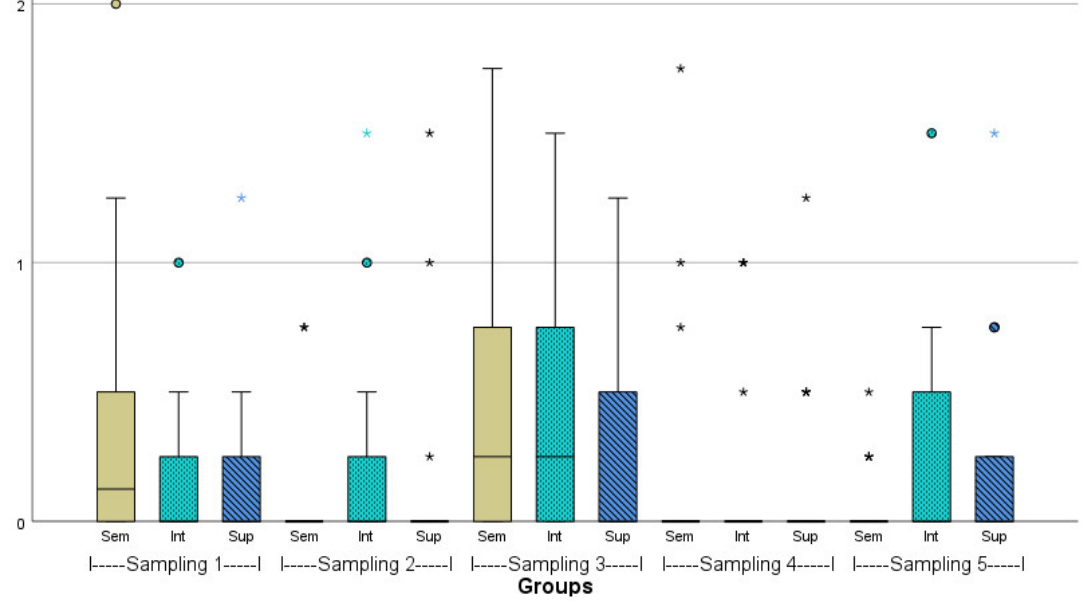
Figure A5. Total skin lesion area of African catfish in three different stocking densities (Sem = semi-intensive, Int = intensive, Sup = super-intensive), n = 18, p > 0.05. In sampling 3, in Sem, a value of 3, and in Sup a value of 4 is not illustrated. Circlets = outliers; asterisks = extreme values.